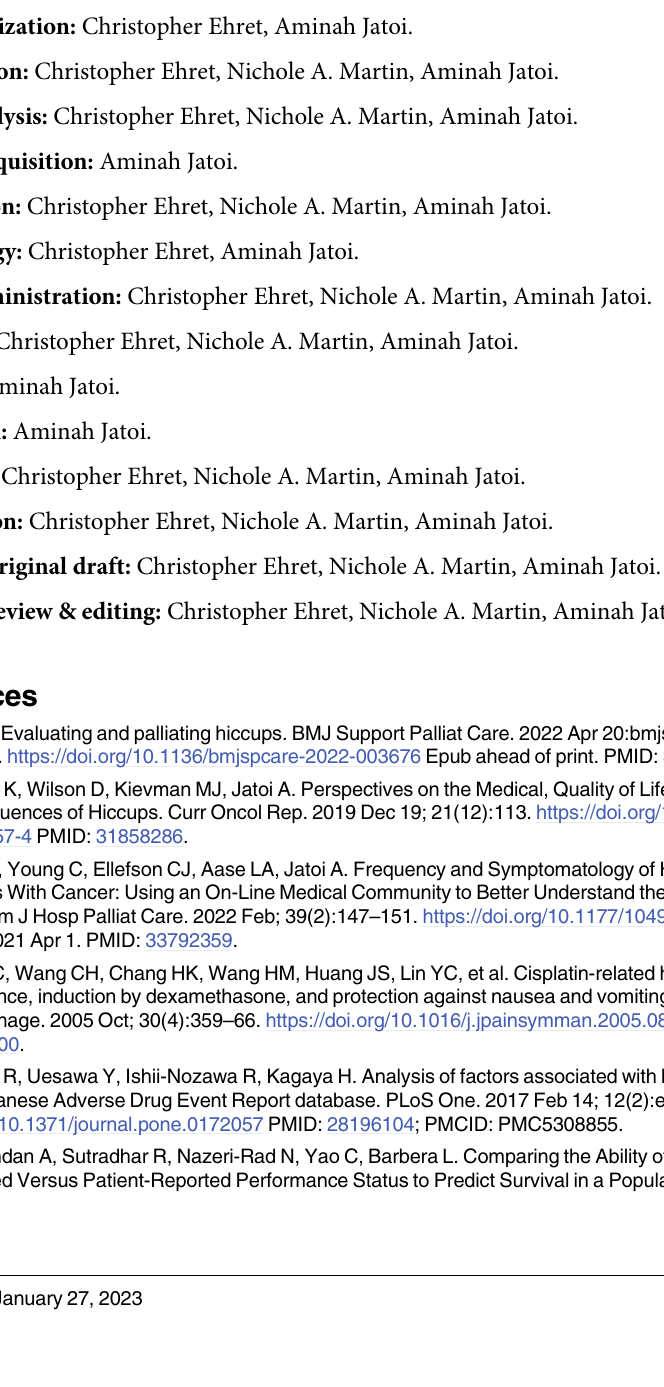
S1 Table. Demographics and other baseline factors; n =